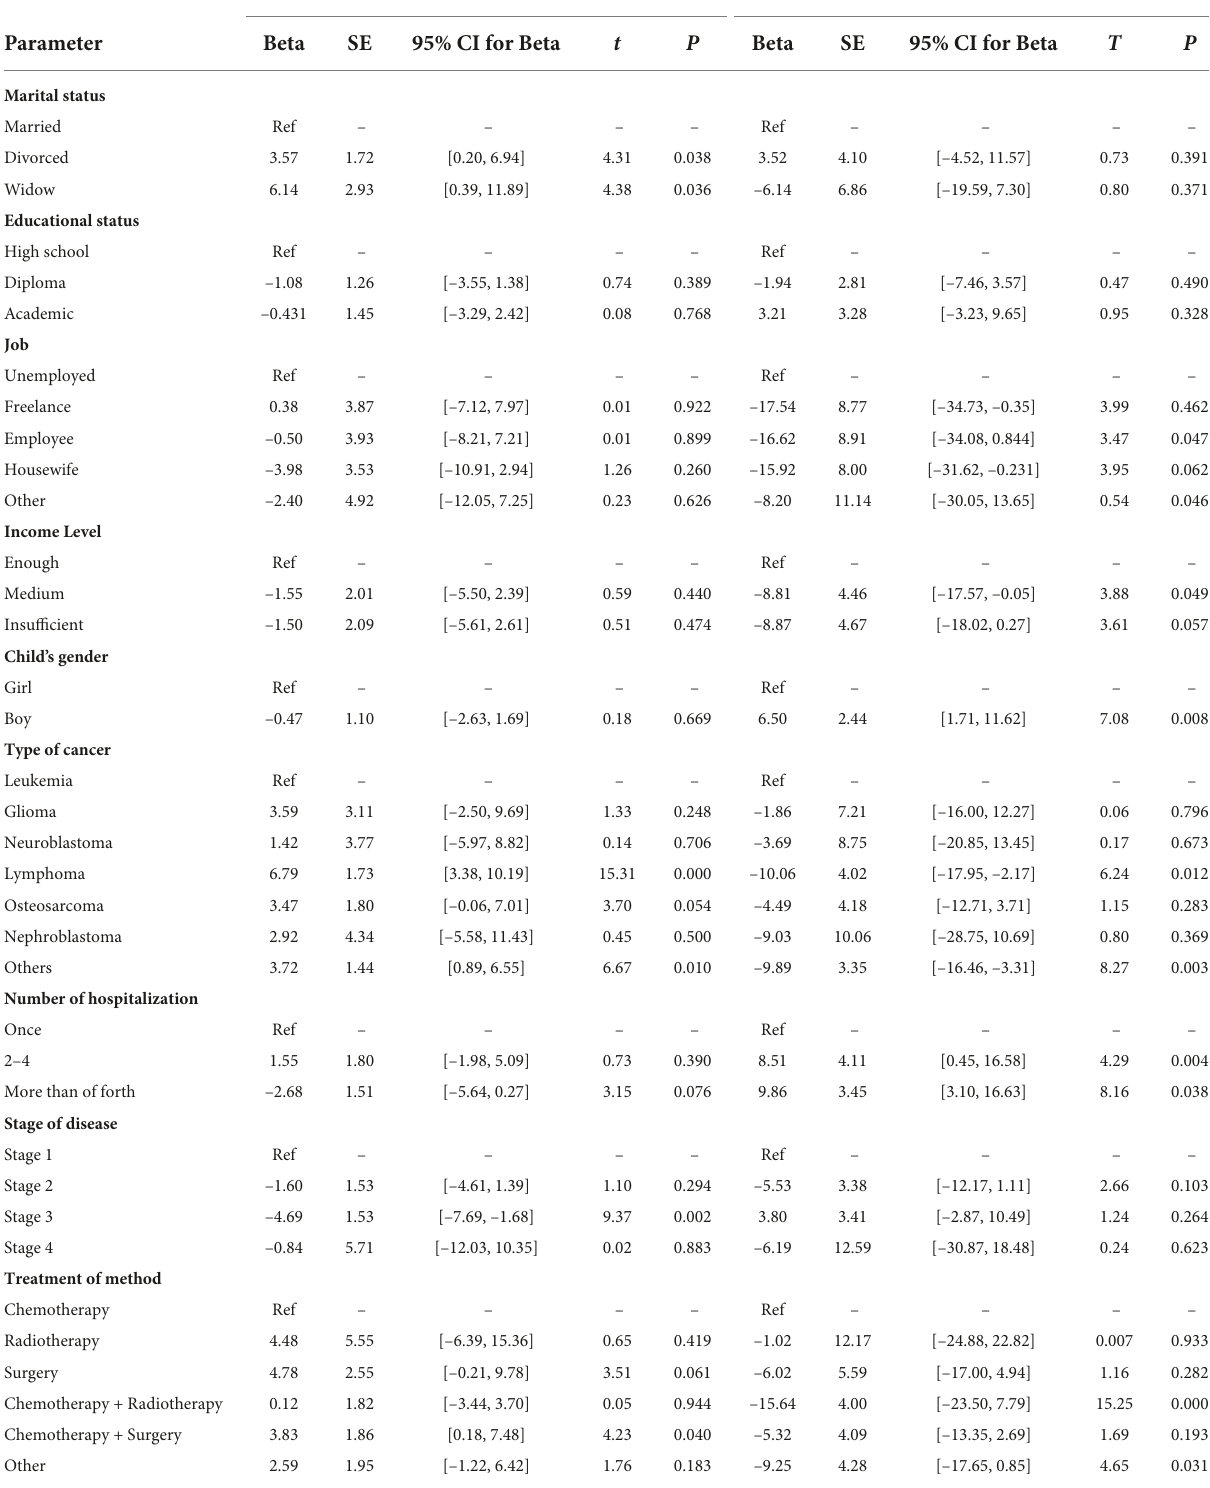
TABLE 4 Result of univariate regression between demographic and professional characteristics and total score of FIN-Import and FIN-Fulment.